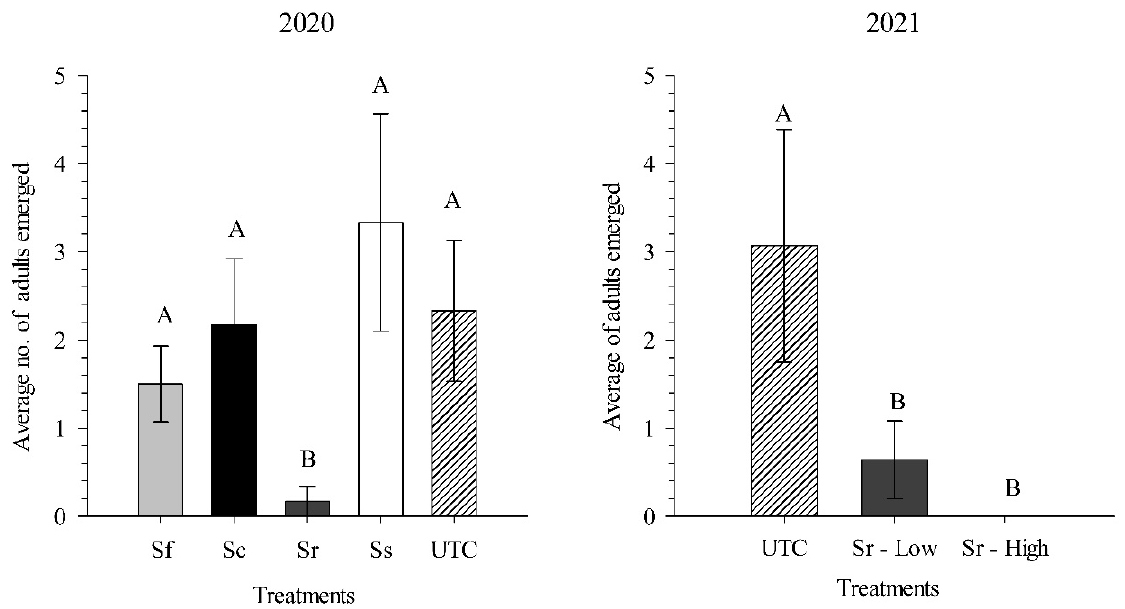
Figure 5. Average number ( ± SEM) of adult Conotrachelus nenuphar emerged from field plots following